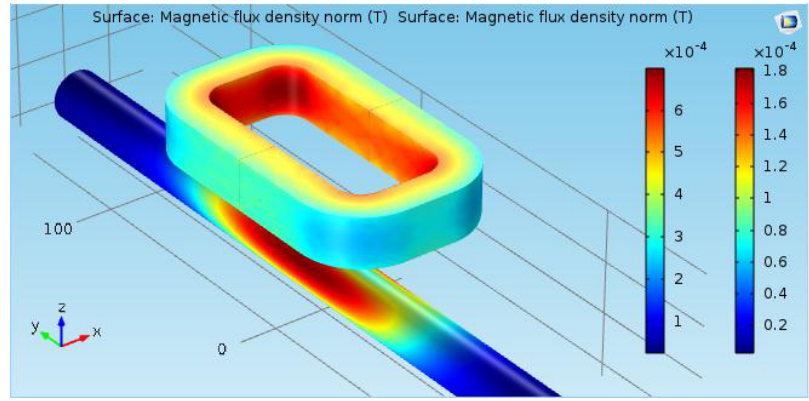
Figure 5. Magnetic flux density at the surface of the coil and the steel bar. Sensors 2015 , 15 , page–page